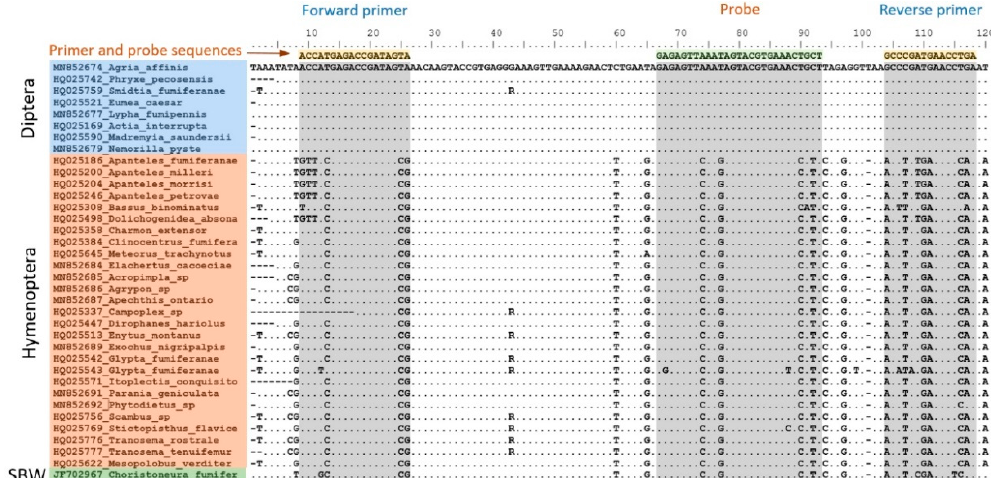
Figure 1. Example of how primers and probes were selected for the development of individual assays making up the molecular sorting tool. Here, the example is given for assay 4-plex 1B, which is aimed at detecting dipteran parasitoids in Module 1. 28S rDNA (region D2) sequences for eight different dipteran species are aligned with several hymenopteran orthologs as well as with the spruce budworm ortholog. Remarkable homogeneity is observed among the dipteran sequences in the regions selected for primer and probe design, while striking differences are seen in the corresponding regions of the hymenopteran and lepidopteran sequences, enabling efficient and selective qPCR amplification and detection of dipteran parasitoids. Alignments used to design primers and probes for the other assays may be found in File S4.